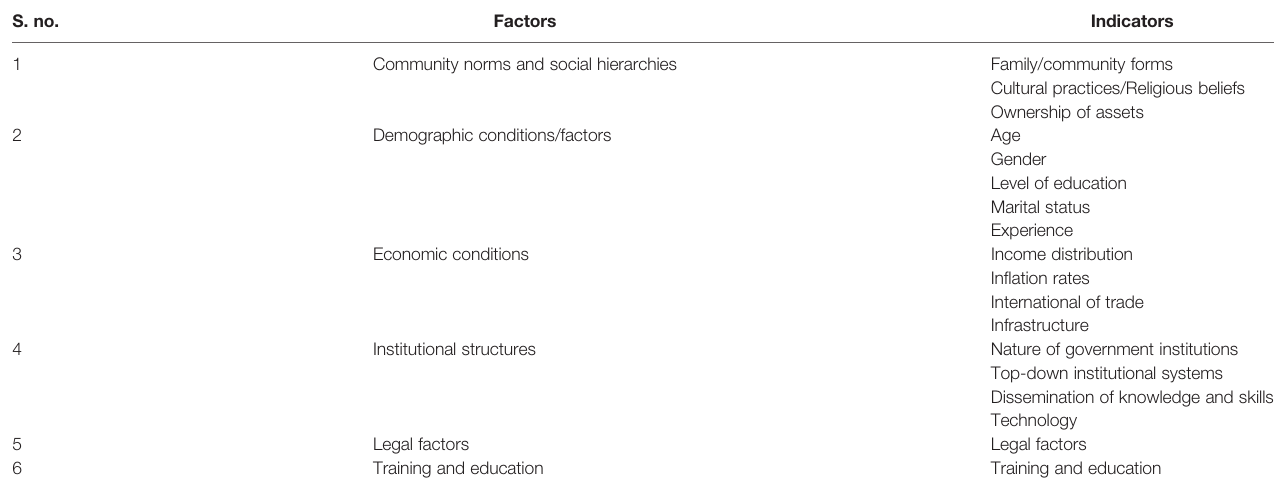
TABLE 5 | In fl uencing factor in ornamental fi sh production. S. no.